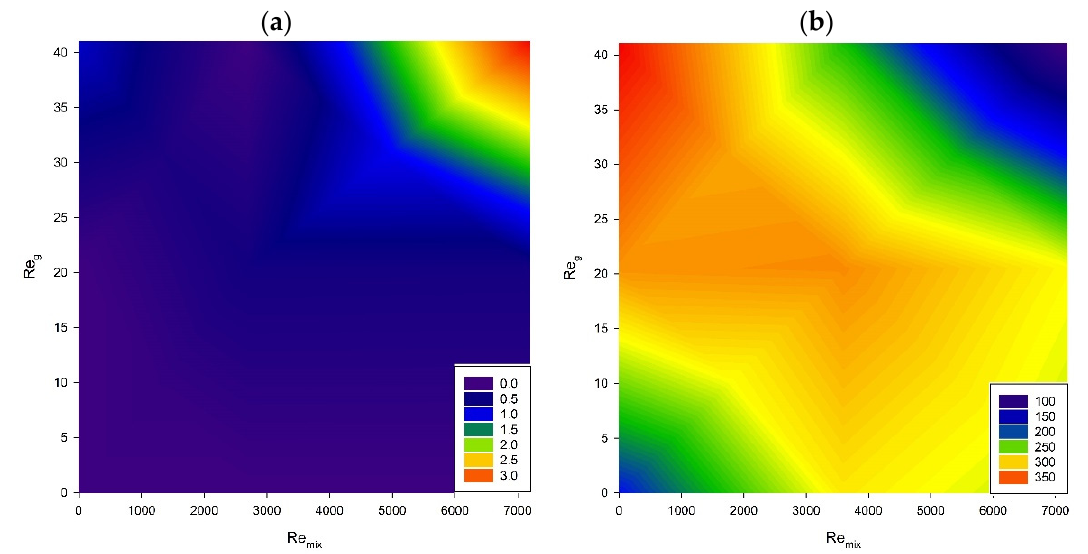
Figure 7. Contour plots of aeration and mixing impact on P. aeruginosa productivity: ( a ) pyocyanin (µg/mL), ( b ) rhamnolipids (µg/mL).